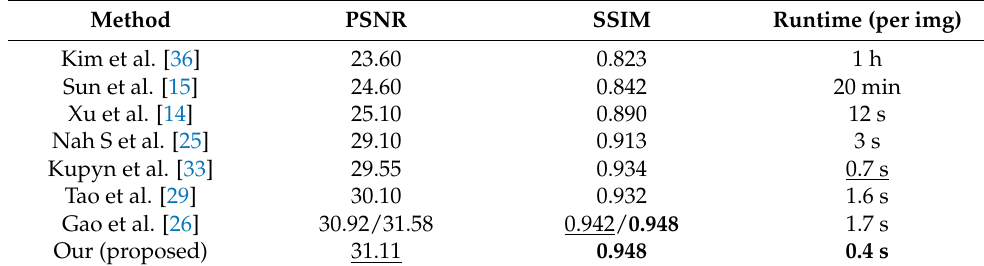
Table 2. Comparison of Different